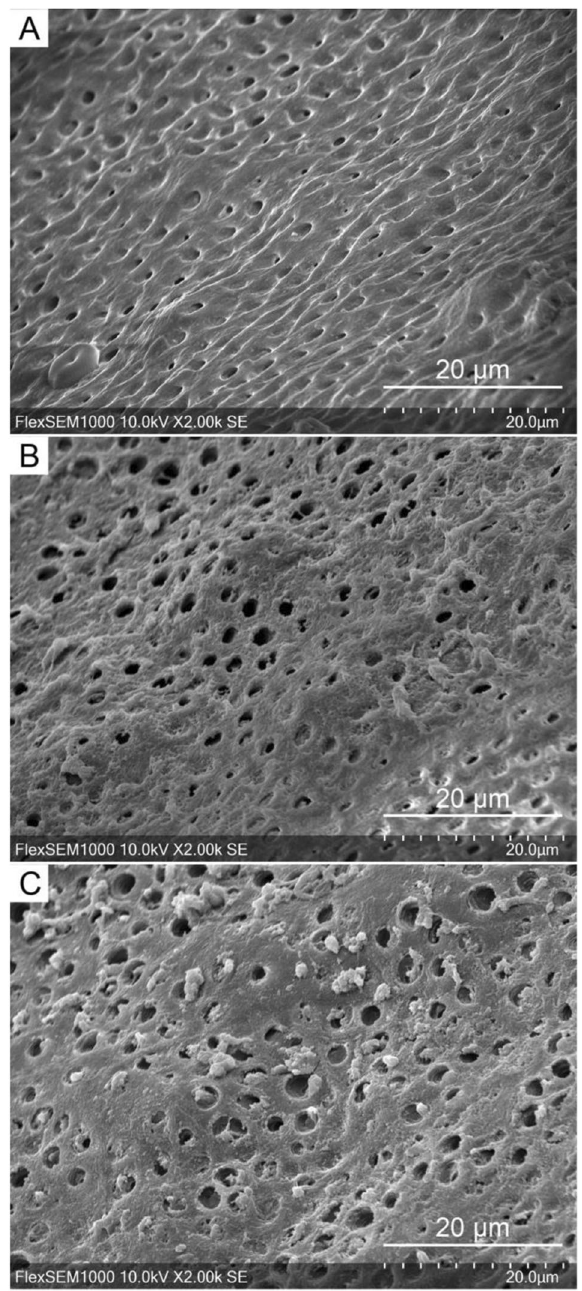
Fig. 1 Scanning electron micrographs of Csnp on dentin surface: no treatment, 2000× ( A ); Csnp with EDC under UA, 2000× ( B ); Csnp with EDC on static immersion, 2000× ( C